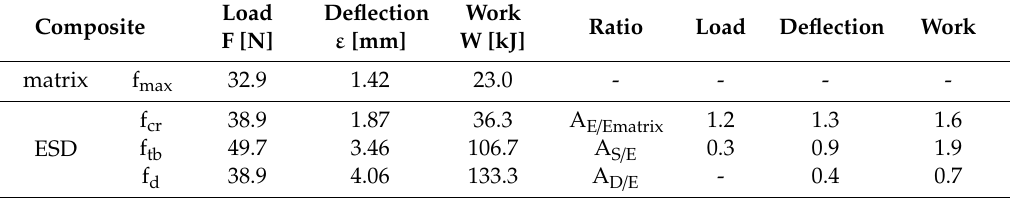
Figure 3. Four-point bending test: ( a ) sample before the test, ( b ) first crack at f cr point, ( c ) multicracking (micro- and macrocracks), ( d ) destruction - propagation process, ( e ) view after the test. Table 1. Mechanical properties of the matrix (concrete without reinforcement) and ESD composite.